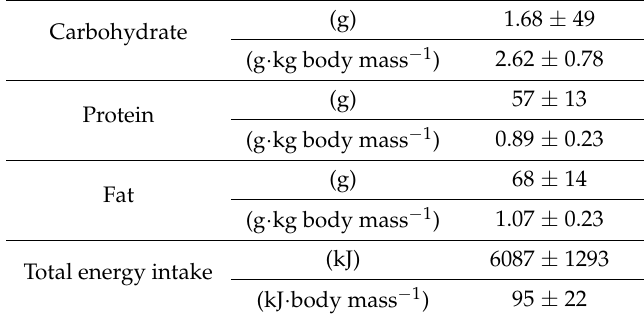
Table 1. Daily dietary intake, with absolute and relative to body mass